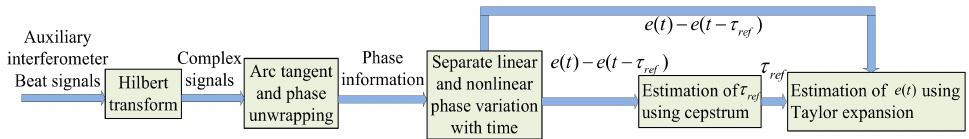
Figure 9. Signal processing procedure of nonlinear phase restoration from an auxiliary interferometer (reprinted from Ding et al. [34] with permission of SPIE; copyright (2014)).